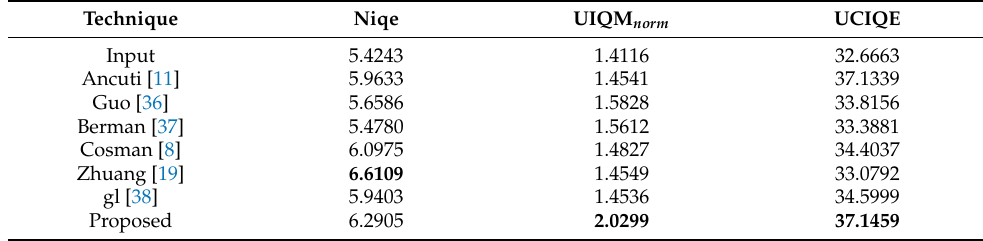
Table 5. Average niqe, UIQM norm , UCIQE comparison of different techniques whose results are partially presented in Figure 9. The best result is bold.